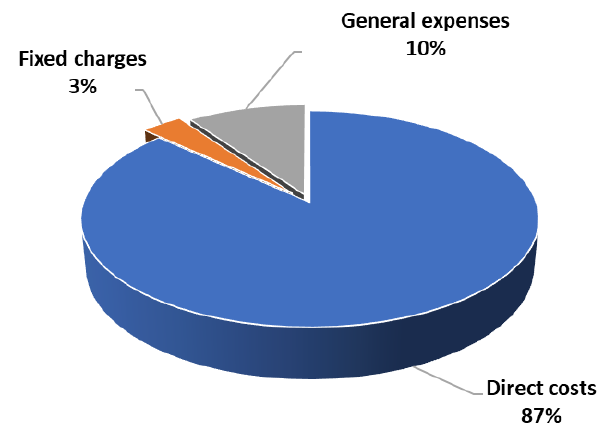
Figure 17. Annual cost distribution of TPC of the glycerol etherification process. Table 8. Details of total capital investment calculations [29].